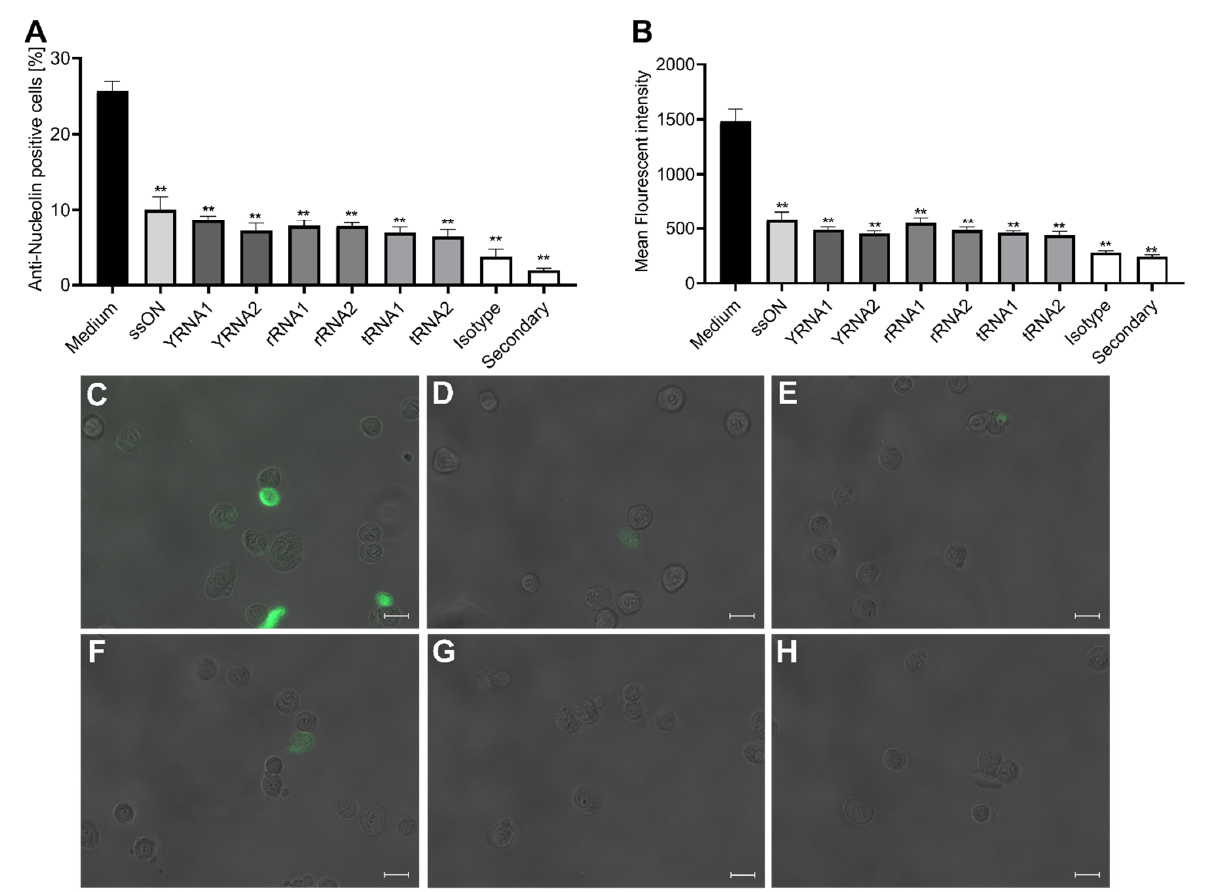
Figure 3. Small non-coding RNAs inhibit antibody binding to the RSV entry co-receptor nucleolin. A549 cells were treated with 35-mer ssON or RNA oligonucleotides (1 µ M) for 15 min, followed by incubation with an anti-nucleolin antibody (1 µ g/mL) for 30 min at 4 ◦ C and then staining with an Alexa 488-conjugated donkey anti-rabbit IgG secondary antibody for 30 min at 4 ◦ C. ( a ) The proportion of cells positive for the anti-nucleolin mAb and ( b ) mean fluorescence intensity (MFI) were measured using flow cytometry. The data are presented as mean ± SEM from three independent experiments conducted in duplicates. Samples containing staining with an isotype control and staining with the secondary antibody alone were included to ensure that no unspecific binding occurred. The nucleolin-positive gate was set according to the isotype control. Significant differences were assessed using the non-parametric Mann–Whitney test, comparing all treatments to the nucleolin control. p -value: ** p ≤ 0.01. Representative microscopy pictures showing nucleolin antibody staining in ( c ) baseline nucleolin control cells, ( d ) ssON-treated cells, ( e ) tRNA2-treated cells, ( f )